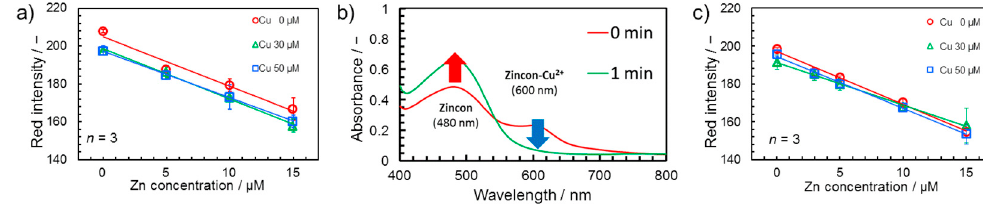
Figure 4. ( a ) Calibration curves for Zn 2+ in the presence of 0, 30, and 50 µ M of Cu 2+ background obtained on devices with glass fiber layers impregnated with salicylaldoxime and buffer components. ( b ) Absorbance spectra in solution showing the delayed kinetics of Cu 2+ masking by salicylaldoxime (detailed experimental conditions available in Section 2.2). ( c ) Calibration curves for Zn 2+ in the presence of 0, 30, and 50 µ M of Cu 2+ background in the sample obtained on devices with glass fiber layers treated with salicylaldoxime, buffer components, and CuCl 2 .